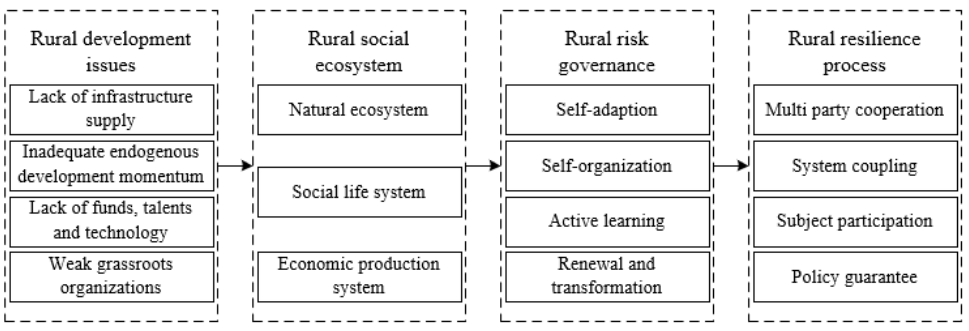
Figure 1. Logical framework of rural resilience (data source: reference [3]).